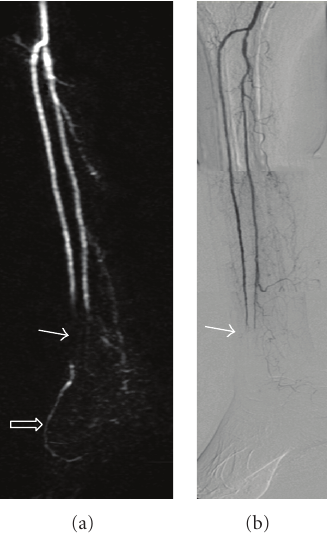
Figure 2: A 67-year-old male with ischemic rest pain and poor healing of the right foot. (a) Targeted peak arterial time frame of T-MRA of the right distal runo ff station in oblique reconstruction demonstrating occlusion of posterior tibial artery and distal third of the anterior tibial and peroneal arteries (arrow). Plantar artery is not visible while dorsalis pedis is patent (open arrow). (b) Corre- sponding DSA demonstrating similar findings to the infrapopliteal portion. The pedal vessels are not opacified. Subsequent surgery confirmed patency of dorsalis pedis artery as demonstrated on T- MRA.